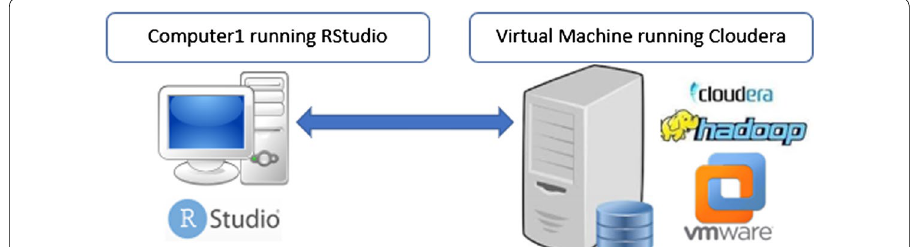
Fig. 1 System architecture: This Figure shows the connection between Computer1 and the Virtual Machine (VM). Computer1 is running RStudio (R Integrated Development Environment) to prepare the connector and the queries in order to communicate with the Big Data platform. The VM hosts a Cloudera with Hadoop in a VMware